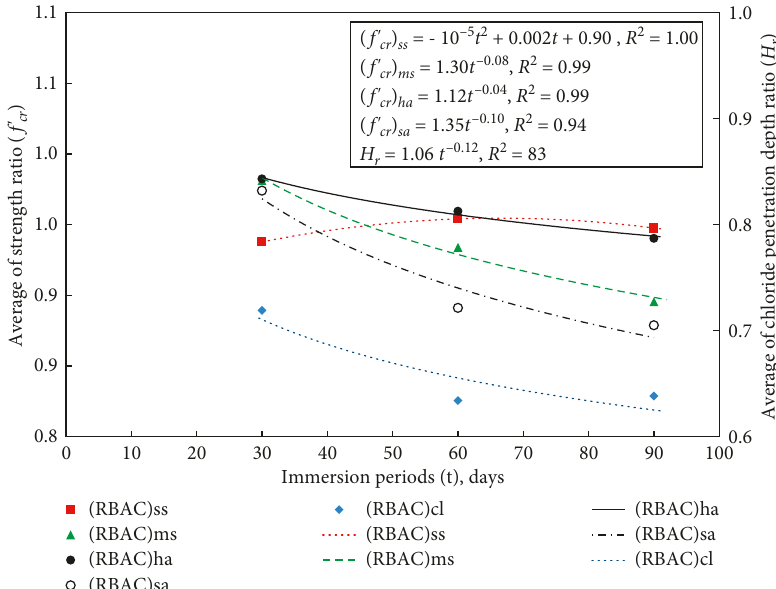
Figure 15: Relationship among the immersion period, average of strength ratio, and average of chloride penetration depth ratio of RBAC immersed in chemical water, respectively ((RBAC)cl � RBAC immersed in sodium chloride